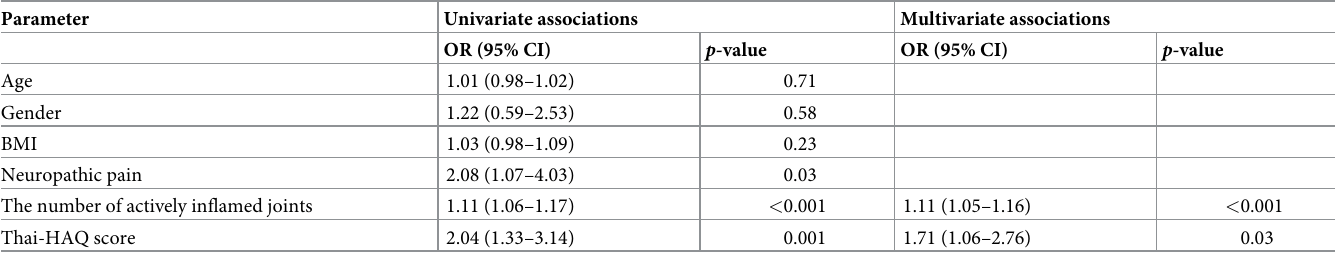
Table 6. Factors associated with the presence of